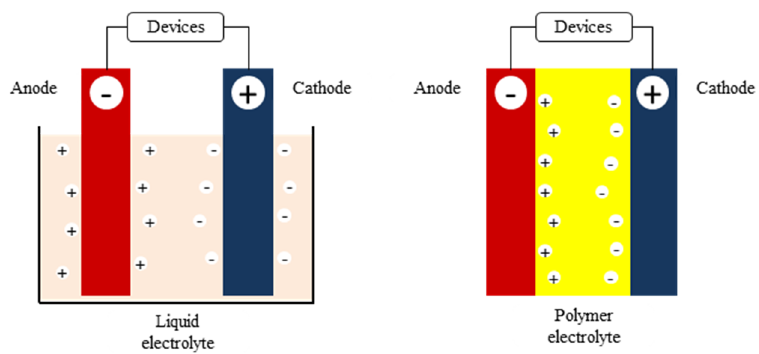
Figure 2. Diagram of a typical electrochemical cell.